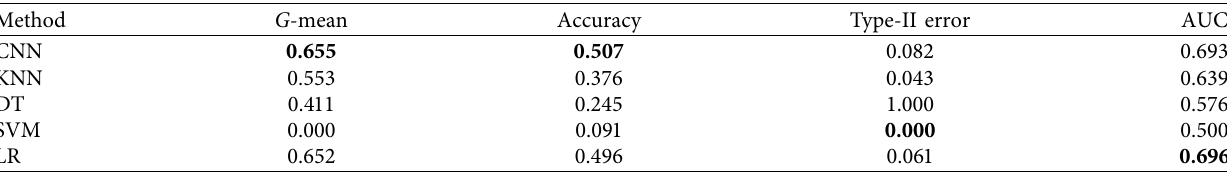
Table 11: The performance of CNN and other four models on CH